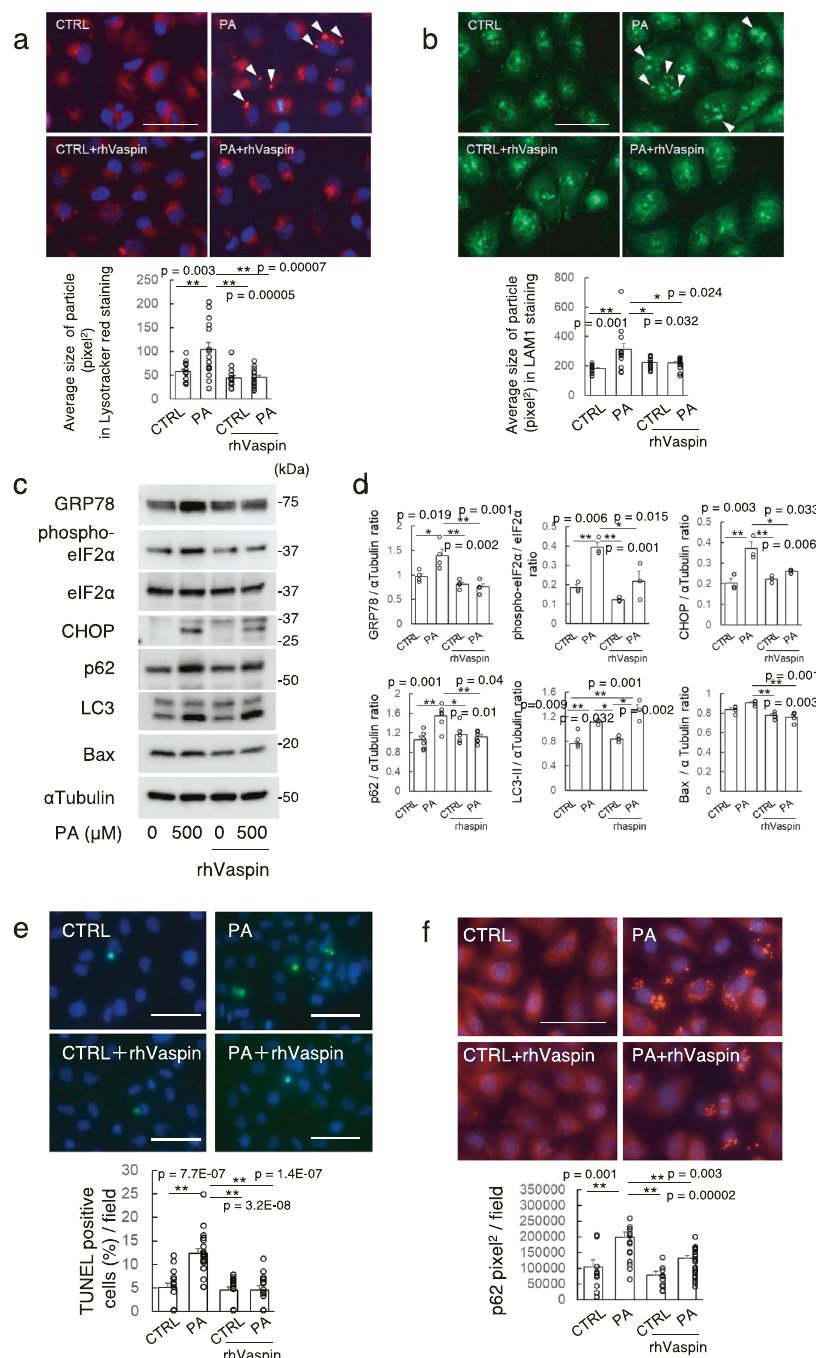
Fig. 2 Palmitate (PA)-induced lysosomal enlargement along with ER stress enhancement in HK2 cells. HK2 cells were cultured with 500 μ M palmitate (PA) or control medium (CTRL) for 24 h. Recombinant human vaspin (rhVaspin) was administrated at 100 ng/ml with PA or CTRL for 24 h. Lysosome were stained by Lysotracker (red) ( a ) and Lamp1 (green) ( b ). Bar = 50 μ m. Average size of Lysotracker Red-positive particle ( a ) and LAMP1-positive particles ( b ) are analyzed. PA-induced p62 accumulation and lysosomal enlargement are inhibited by rhVaspin. Bonferroni test is used for assessment. c Western blot analyses. d Densitometric analysis of western blots, n = 3 – 4 independent experiments. One-way ANOVA with Tukey – Kramer method is used for assessment, except for CHOP which is analyzed by Bonferroni test. e TUNEL assay of HK2 cells cultured with 0 or 250 μ M PA for 24 h. Bar = 100 μ m. Lower panel shows percentage of HK2 cells with TUNEL positive apoptotic cells per fi eld. N = 16-21 independent cells. One-way ANOVA with Tukey – Kramer method is used. f . Cells were fi xed with methanol, then stained with anti-p62 antibody. Bar = 50 μ m. Lower panel statistical analysis of pixel 2 of p62 area, n = 10 – 25 independent cells. One-way ANOVA with Tukey – Kramer method is used. All data are presented as mean ± S.E., * p < 0.05, ** p < 0.01. Western blots and fl uorescence studies were repeated